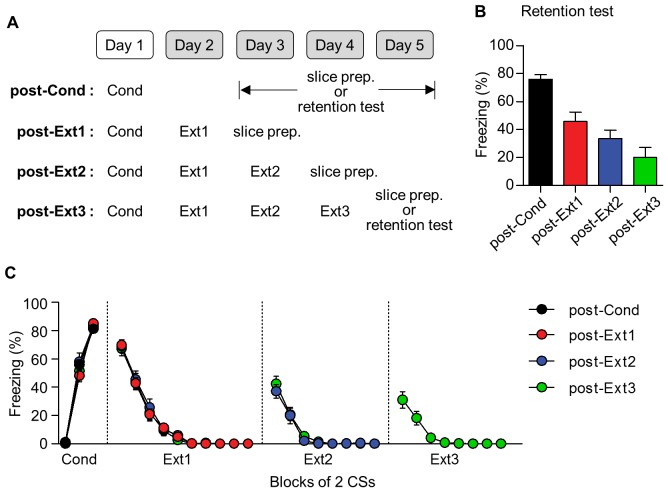
The behavioral results for the electrophysiological experiments shown in Figures 3–5.An additional set of rats was used to monitor conditioned freezing for the retention test. (A) Experimental design. One set of rats was killed to prepare brain slices for the electrophysiological experiment (the number of rats; post-Cond = 61, post-Ext1 = 52, post-Ext2 = 25, post-Ext3 = 21), and another set of rats was used for the retention test (the number of rats; post-Cond = 16, post-Ext3 = 6). (B) Summary of conditioned freezing during the retention test for all behavioral groups. The retention test in the post-Ext1 and post-Ext2 groups represented the average of the first two data points in Ext2 and Ext3, respectively. (C) The freezing responses from consecutive behavioral sessions for all behavioral groups.